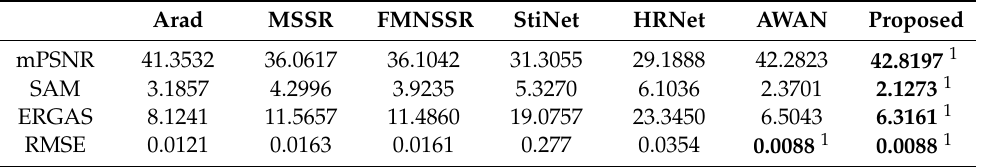
Table 2. Quality assessment comparison on the Pavia University data